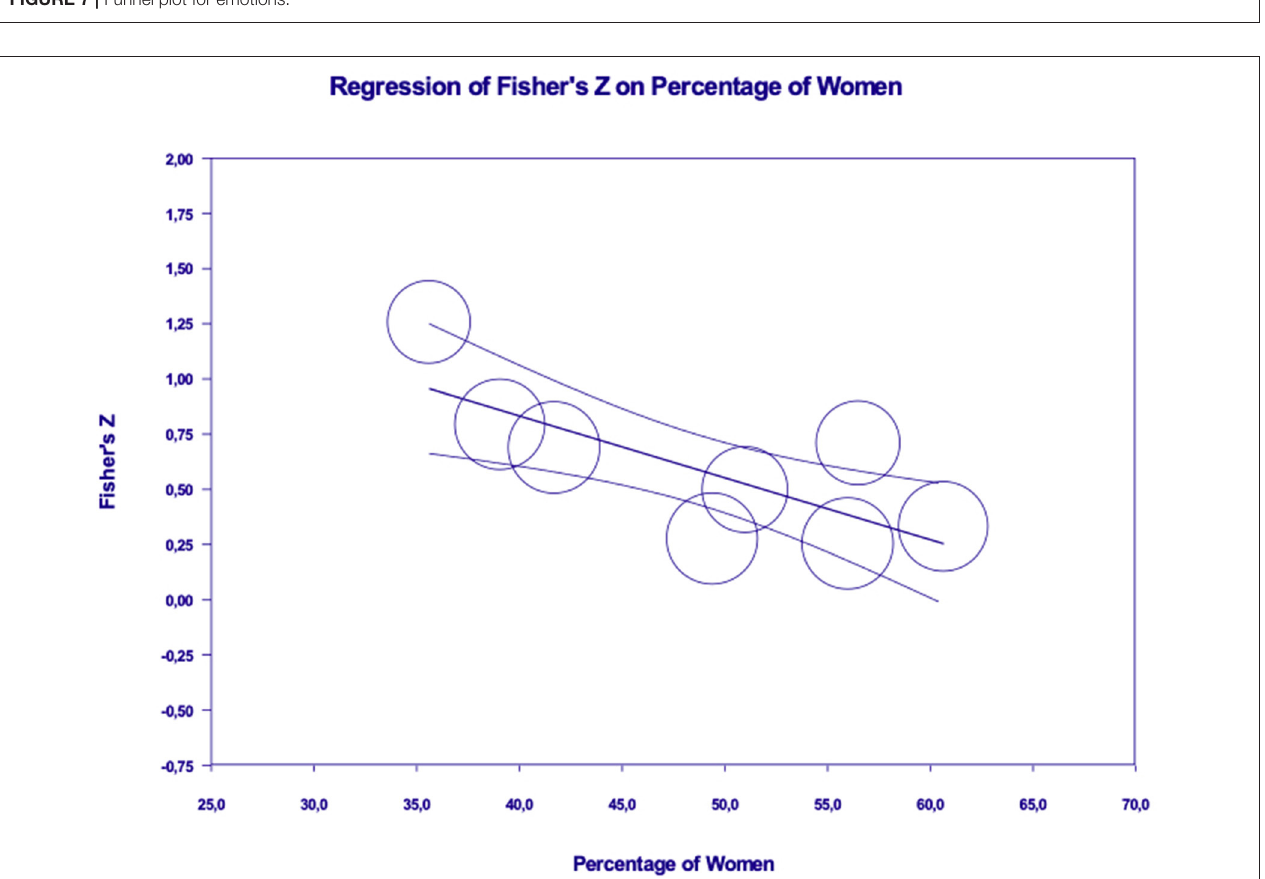
FIGURE 8 | Moderation effect of gender in the relation between emotions and energy saving behaviors (or intentions).